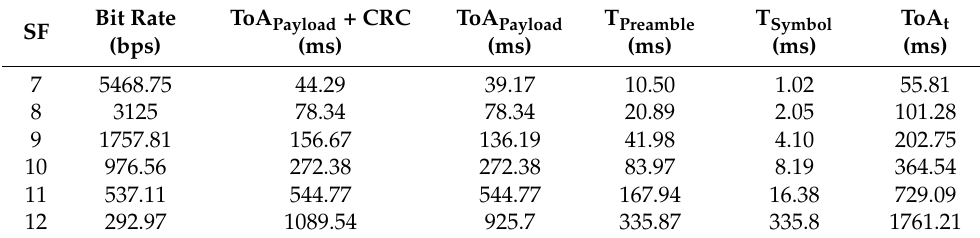
Table 3. Performance of a